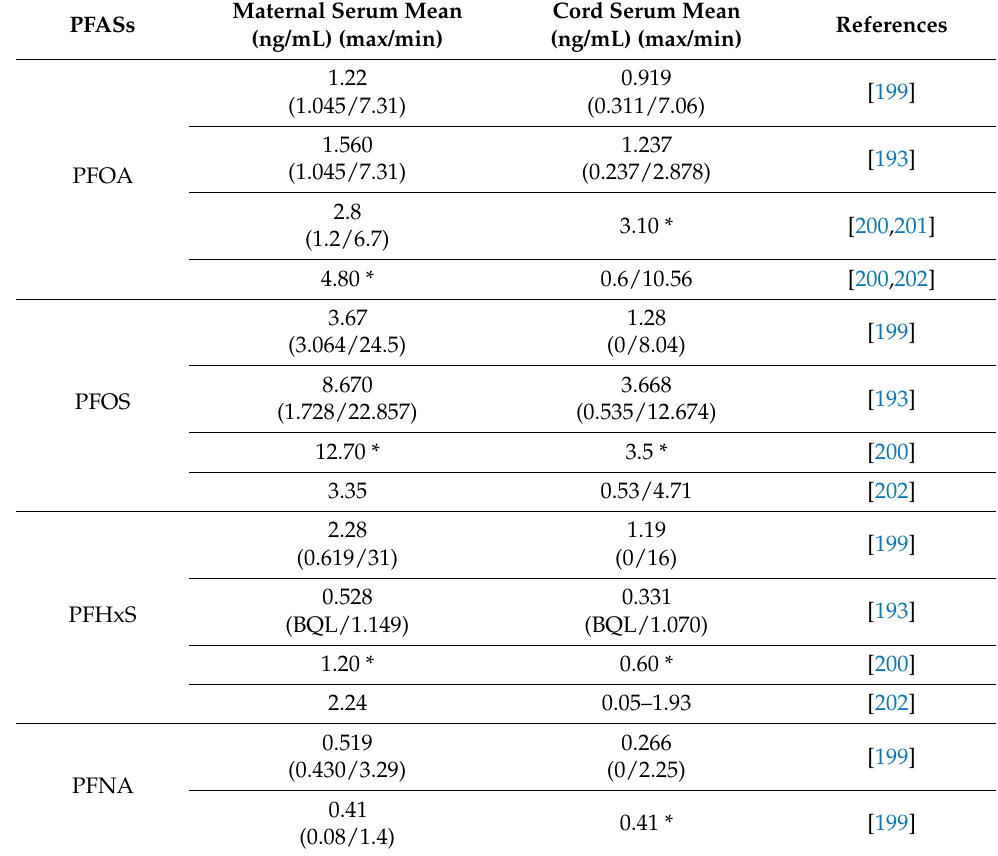
Table 6. Different concentrations of PFASs determined in human serum from blood of mothers